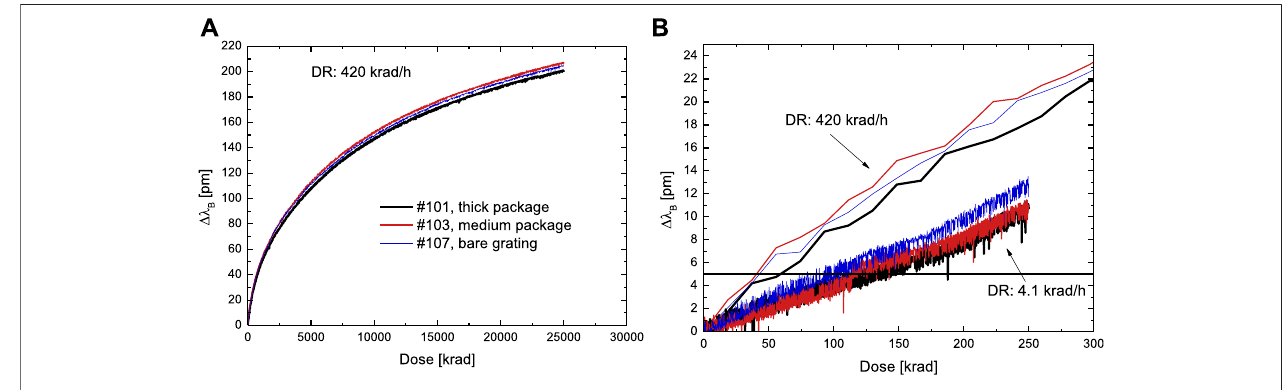
FIGURE 11 | (A) CWL shift with 25Mrad at a dose rate of 420rad/h, (B) CWL shift at 300krad total dose (420rad/h vs